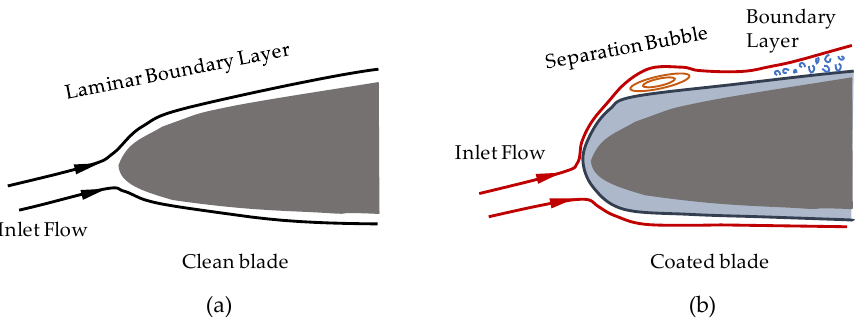
10 of 26 Figure 9. Schematic of erosion blades: ( a ) Erosion of chord over the outer 50% height; ( b ) degree of erosion in different blade height sections. Reproduced from [12]. Elmstrom [55] suggested that although the blade coating is essentially an additive